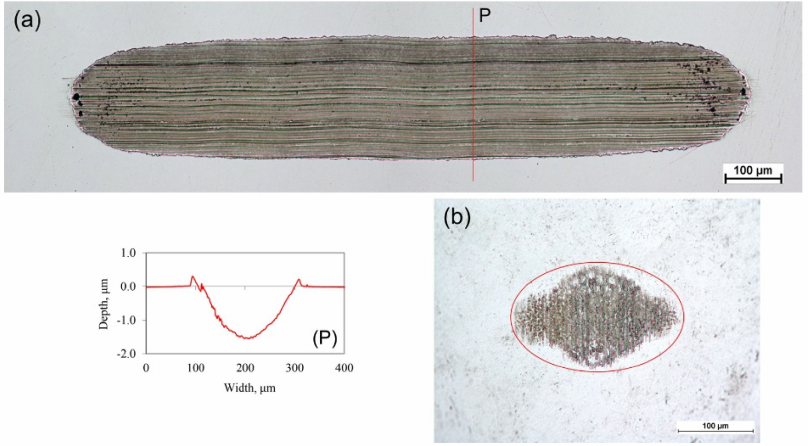
Figure 12. Optical image and cross-section profile of wear trace on the plate ( a ) and wear scar on the ball ( b ) formed during the W + IL-DEE tribo-test P is the cross-section profile of the wear trace measured in a particular location.